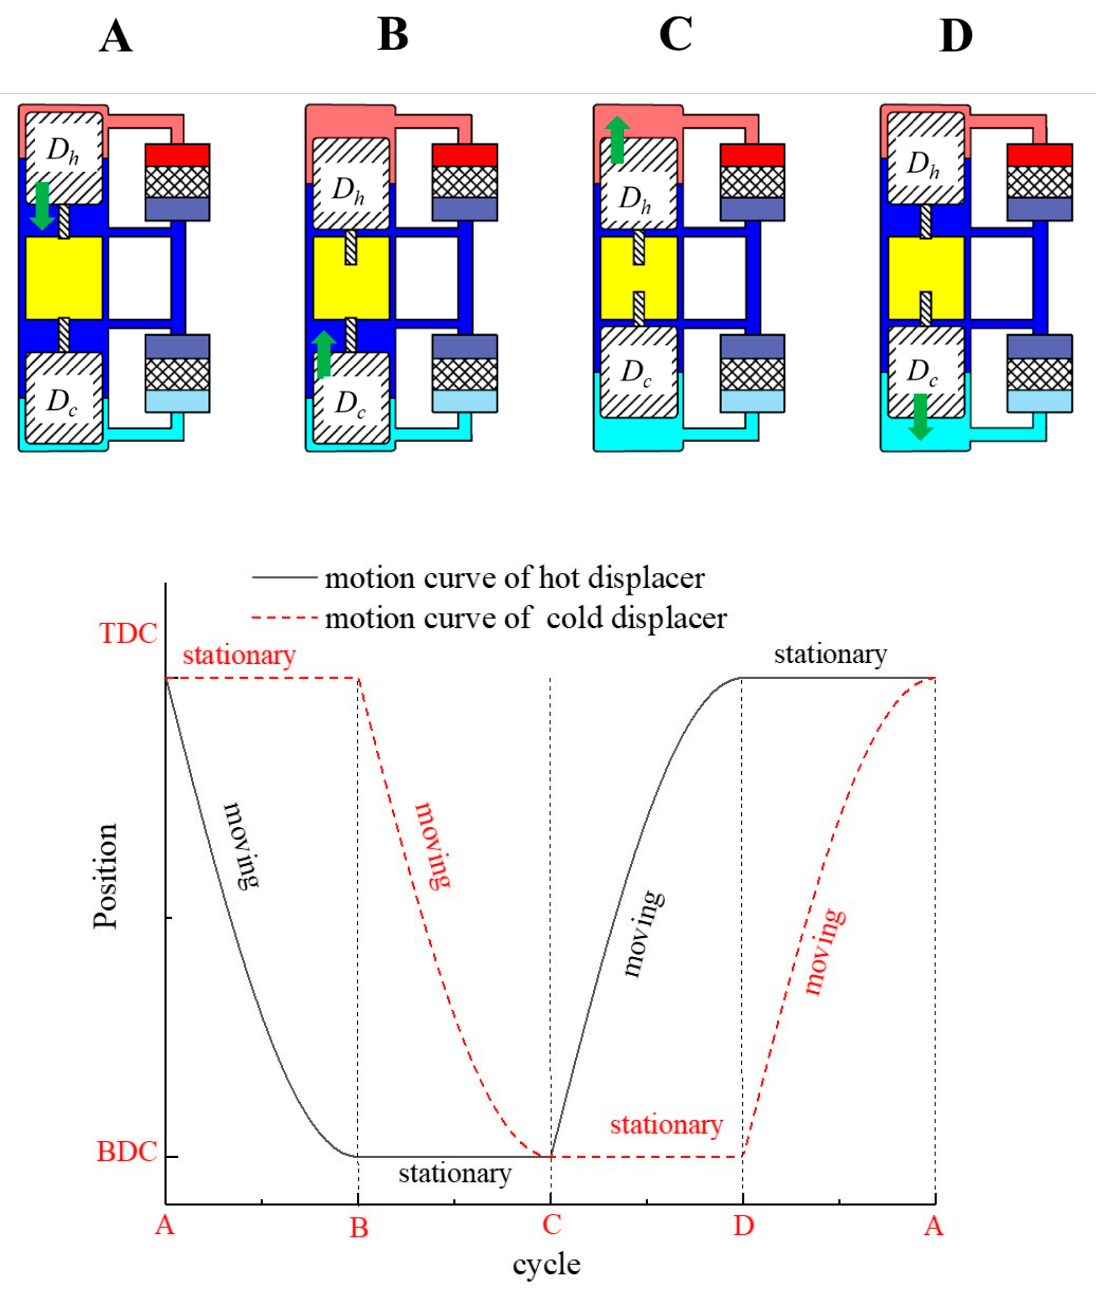
Figure 2. Schematic of motions of displacers in HVCHP.